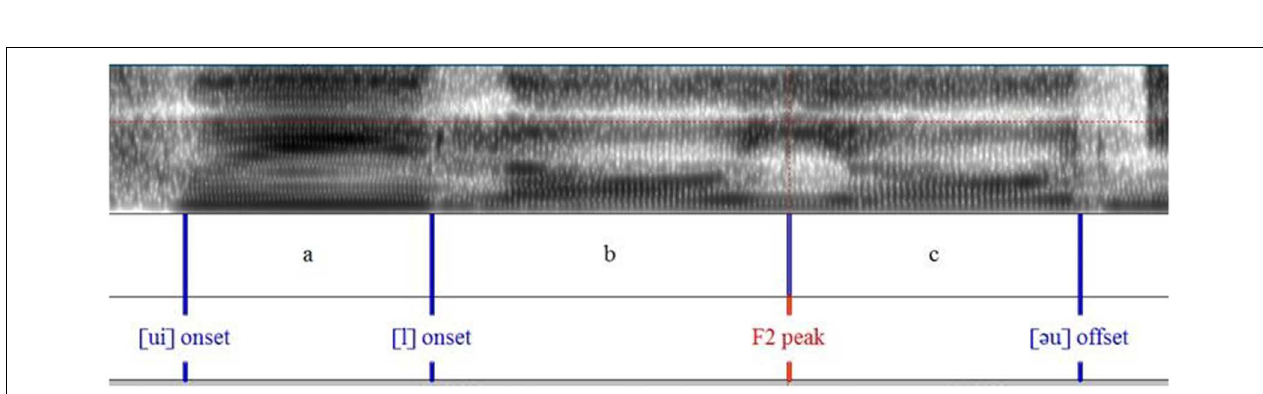
Frontiers in Psychology |